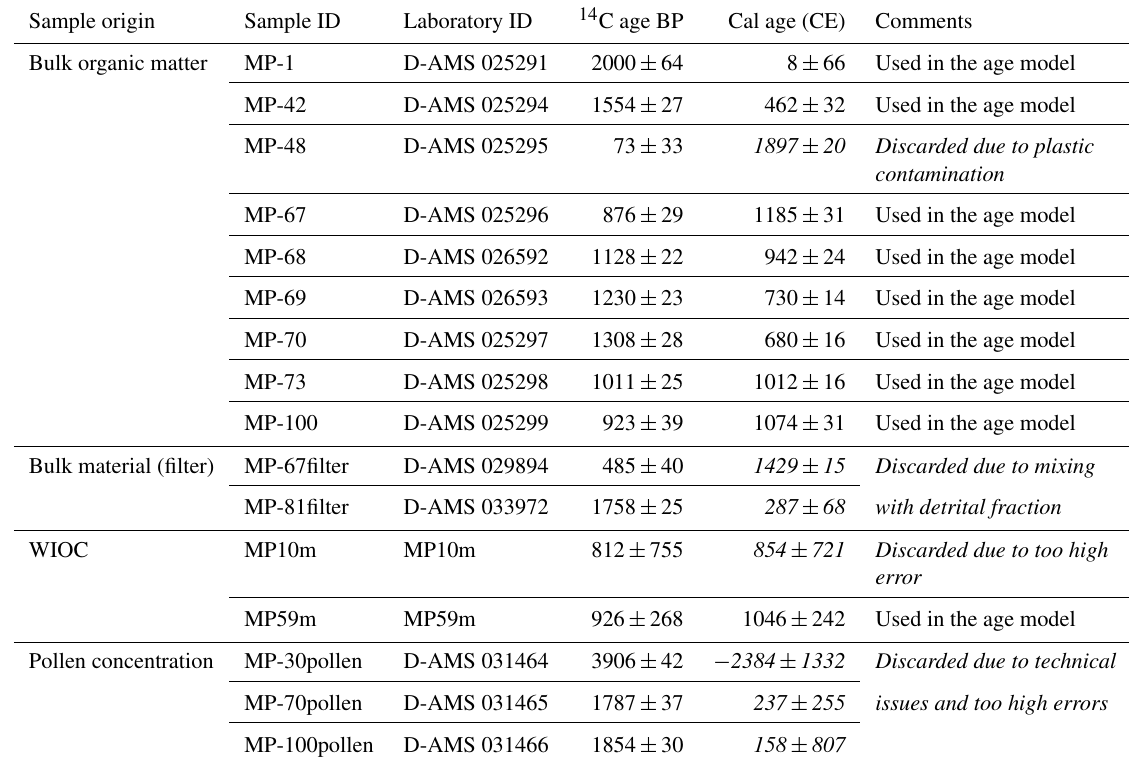
Table 3. Radiocarbon dating of MPG samples indicating their origin, the radiocarbon age ( 14 C age BP) and the calibrated date using the IntCal13 curve and presented in calendar years of the Common Era (CE). Samples in italics were not included in the depth–age model (see column “Comments” and text for